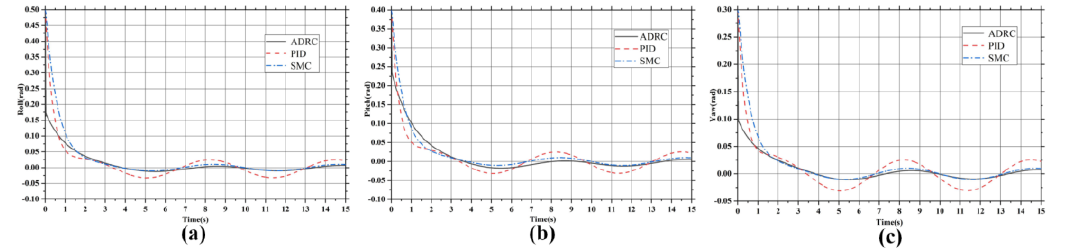
Figure 6. Simulation results of PID, SMC and ADRC out-of-water motion attitude angle control: ( a ) roll angle, ( b ) pitch angle, ( c ) yaw angle.